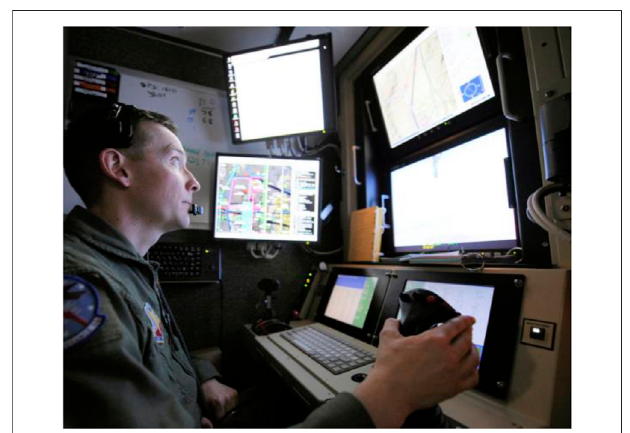
FIGURE 1 | Cockpit for remote drone teleoperation. Pilots need to processnumeroussensorswhilehandlingmissiontaskswithmultiplecontrols in stressful situations. (wikipedia.org/wiki/File: 6th_Reconnaissance_Squadron_-_Operator.jpg, public